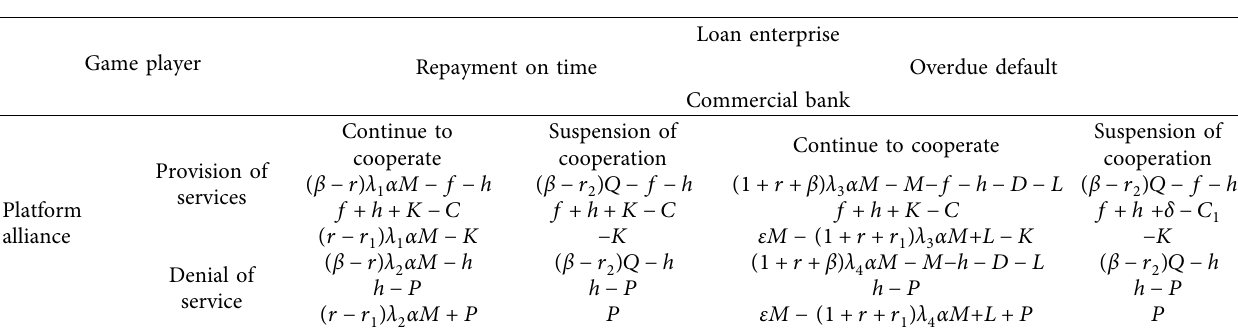
Table 2: Game benefit matrix